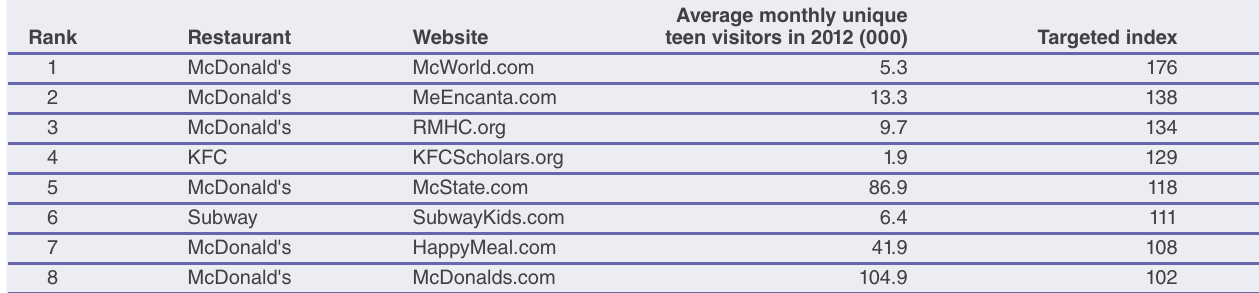
Table 27. Websites with relatively high compositions of teen